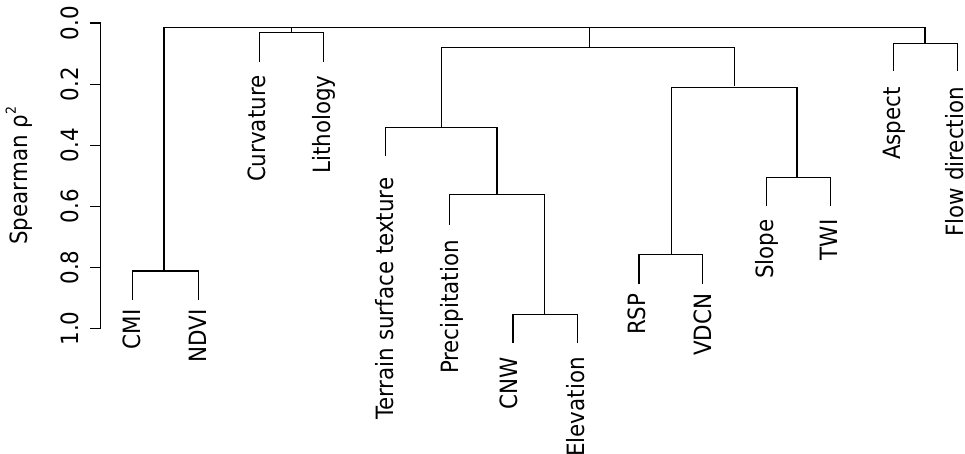
Figure 3. Dendogram of Spearman’s correlation among covariates. CMI = clay mineral index; CNW = channel network base level, correlation among covariates; RSP = relative slope position; VDCN = vertical distance to channel network; TWI = topographic wetness index; NDVI = normalized difference vegetation